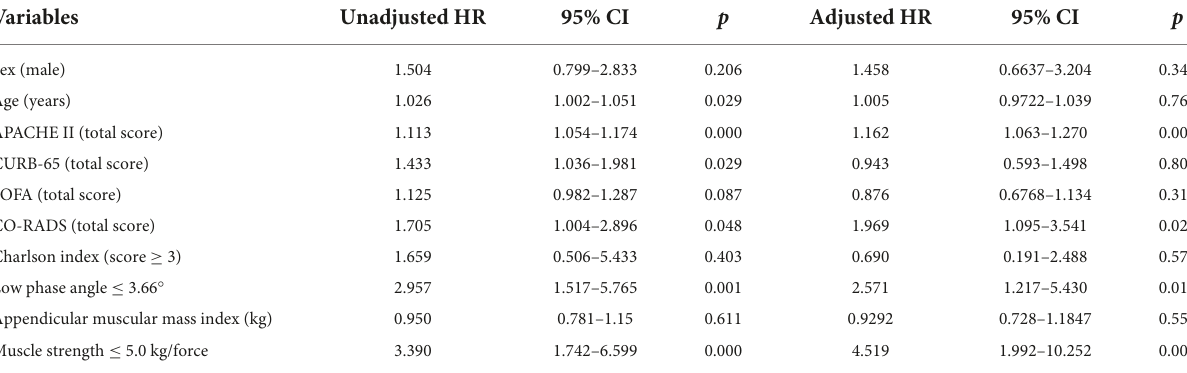
TABLE 2 Association between low phase angle, low muscle strength, and severity scales with mortality.